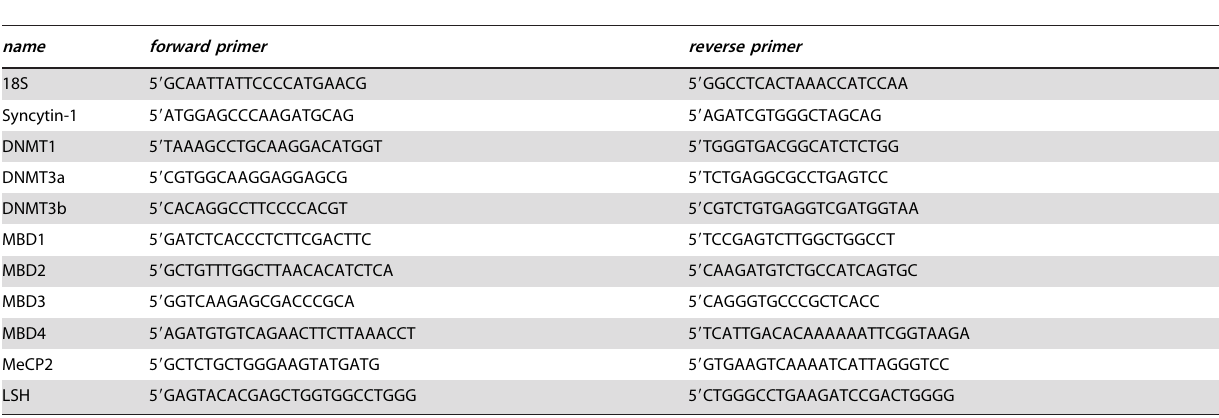
Table 2. SYBR-Green primers for real time